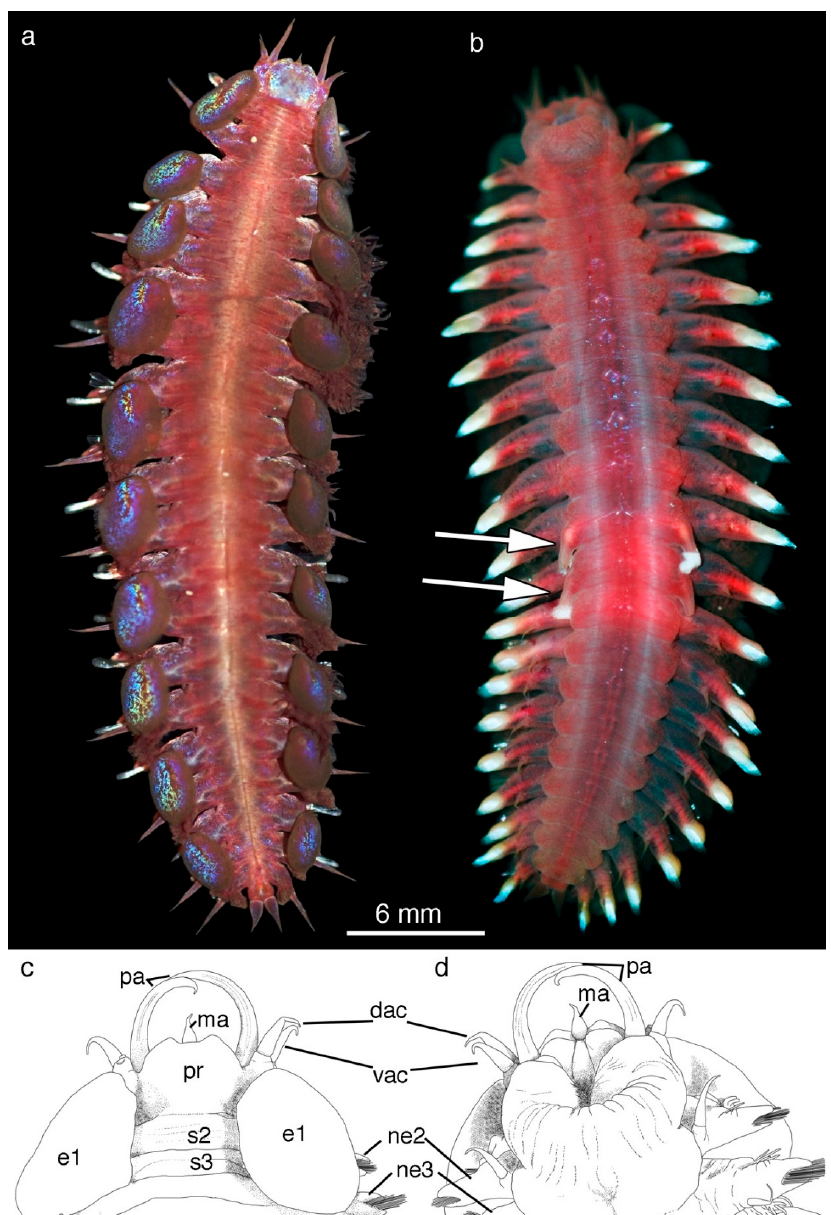
Figure 9. Branchipolynoe halliseyae n. sp. female holotype (SIO-BIC A1322) ( a ). Dorsal view. ( b ). Ventral view. Arrows indicate elongated ventral papillae of Segments 11 and 12. ( c ). Drawing of dorsal anterior. ( d ). Drawing of ventral anterior. Abbreviations: pa, palps; ma, median antenna; pr, prostomium; e1, first elytron (attached on Segment 2); s2 and s3, Segments 2 and 3; dac, dorsal anterior cirrus; vac, ventral anterior cirrus; ne2 and ne3, neuropodia 2 and 3; vc2, ventral cirrus on Segment 2.